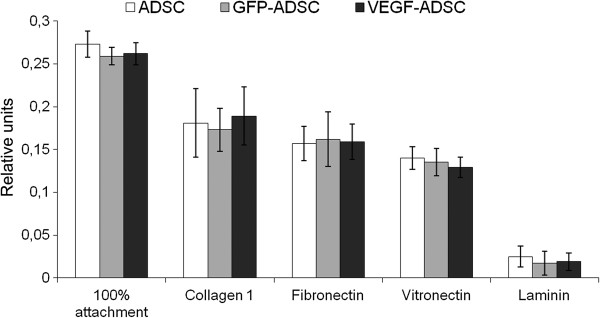
Data from comparative study of ADSC, GFP-ADSC and VEGF-ADSC adhesion on culture plates coated by collagen 1, vitronectin, fibronectin or laminin (n=4).